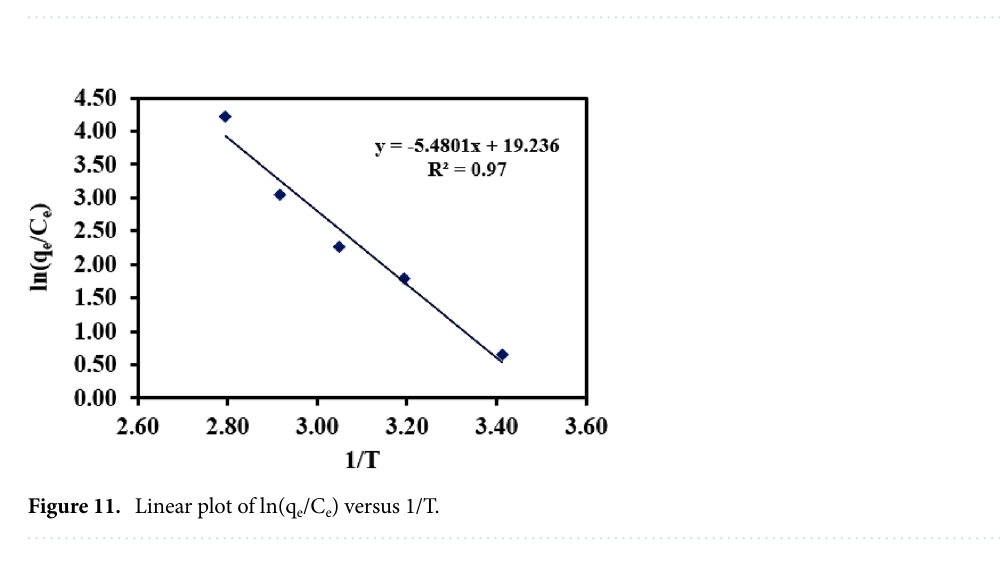
Table 2. Constants and coefficients of determination of isotherm models.